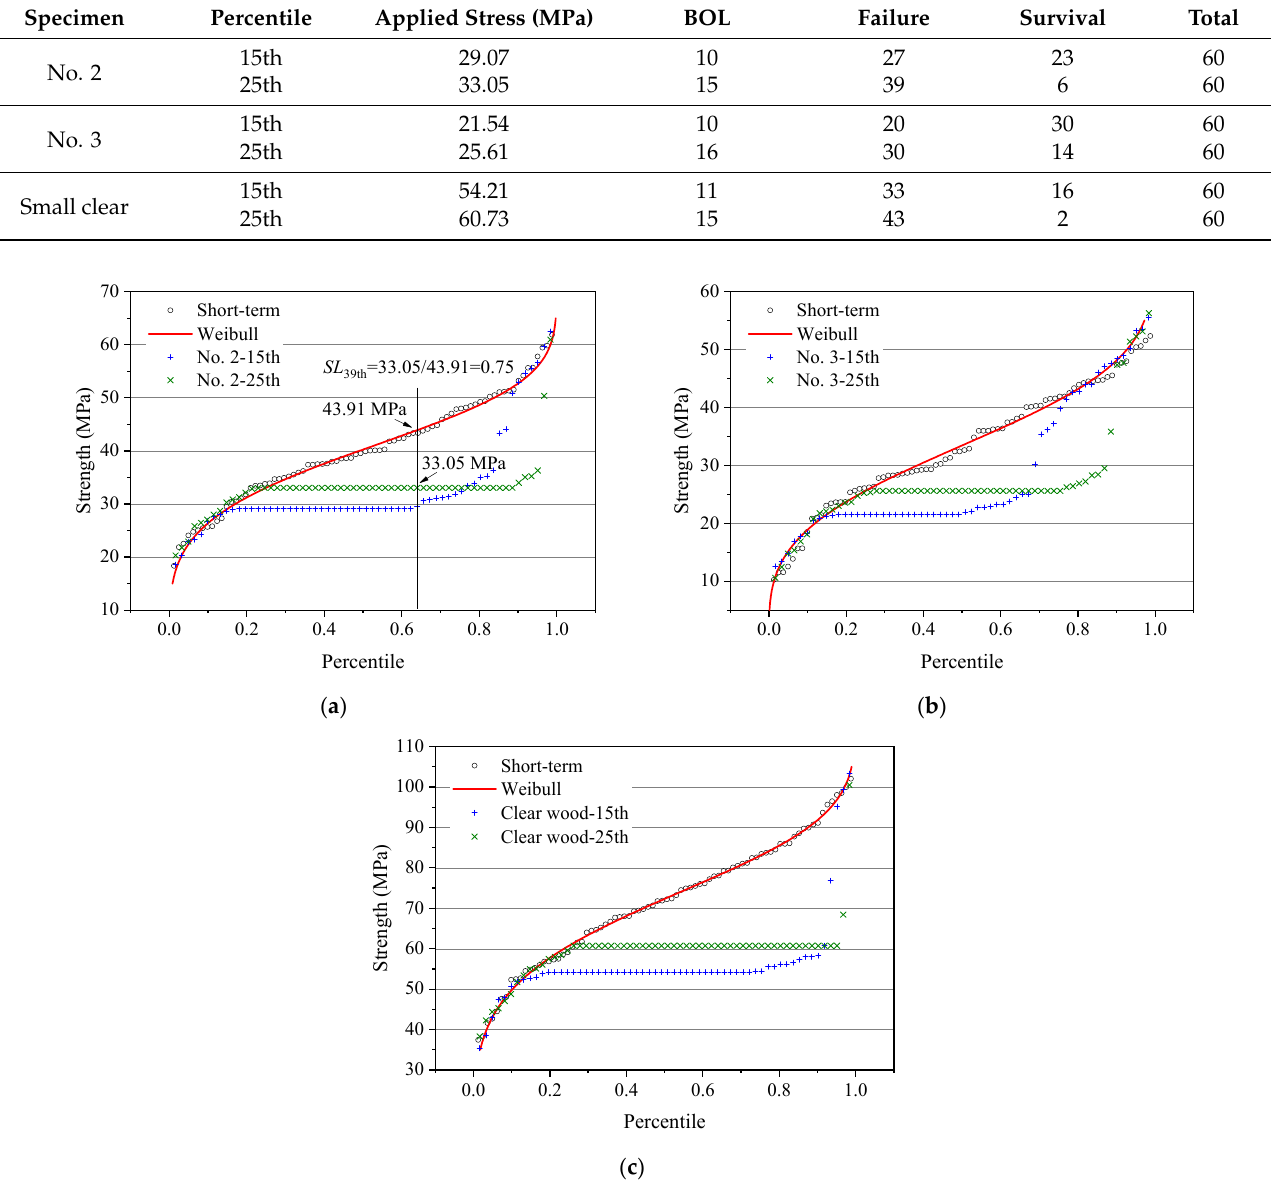
Figure 5. Short-term and long-term strength from the tests. ( a ) Grade No. 2 dimension lumber, ( b ) Grade No. 3 dimension lumber, ( c ) Small clear specimen. Table 4. Applied stress and specimen failure result in long-term tests.